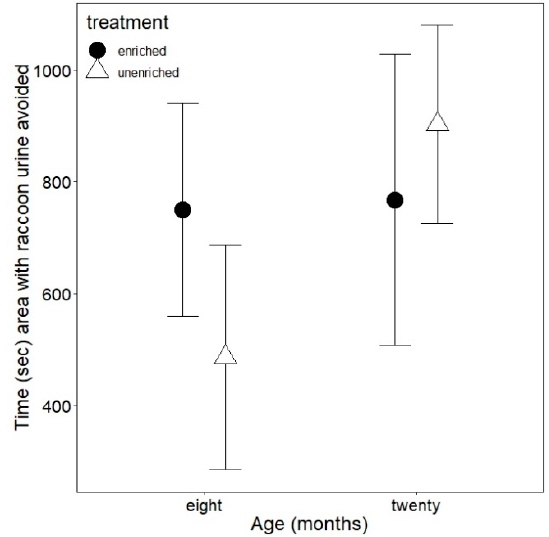
Figure 5. Time (seconds) enriched and unenriched captive-reared eastern box turtles ( Terrapene carolina ) spent away from a side of an experimental arena scented with northern raccoon ( Procyon lotor ) urine when eight and 20 months old. Symbols represent means and bars are 95% confidence